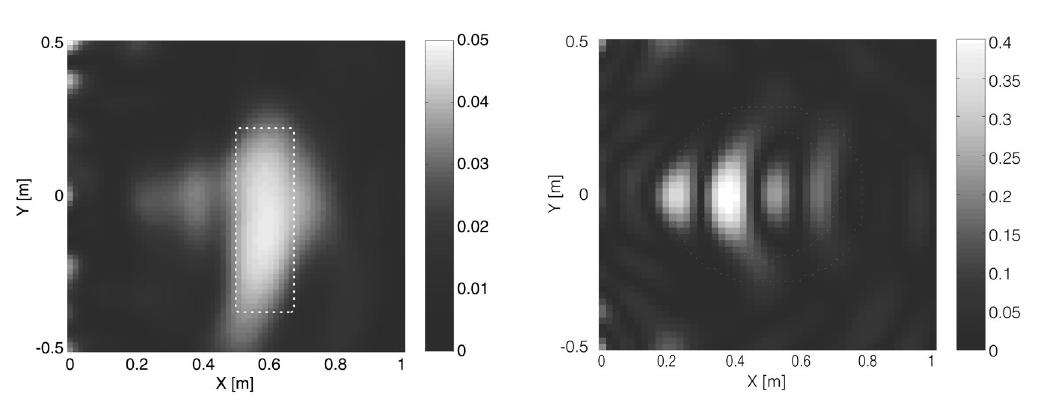
Fig. 9. Case 2: a conductivity anomaly. Modulus of the reconstructed contrast when considering noise- corrupted data (SNR = 10 dB).